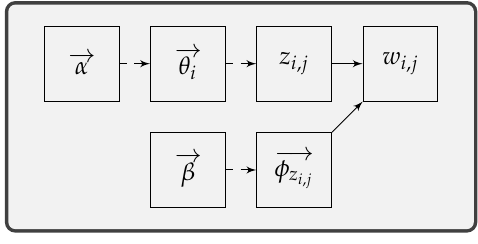
Figure 1. The generation of a document under LDA